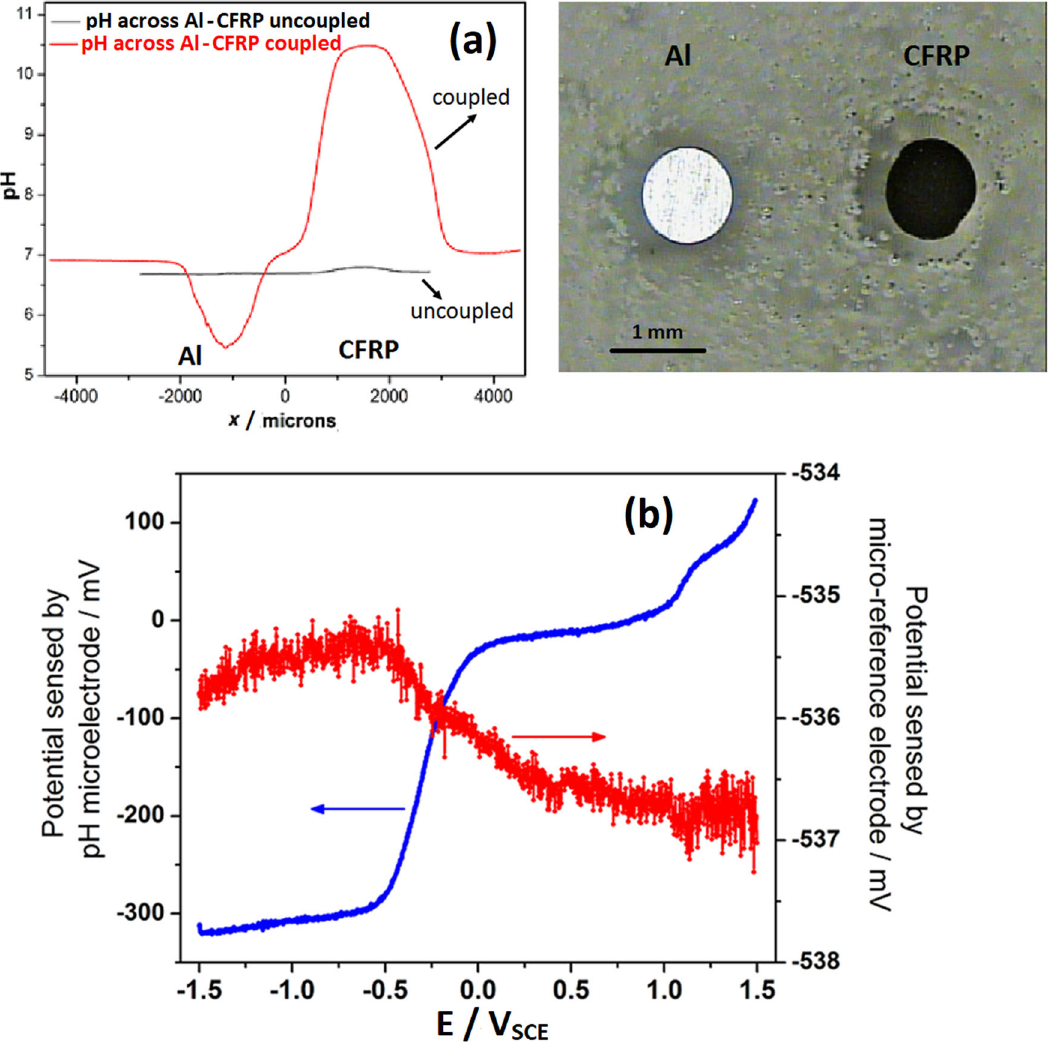
Fig. 12 Variation of local environment around Al and CFRP in Al-CFRP. Local environment information around CFRP and aluminium a pH pro fi le across Al and CFRP galvanically coupled and uncoupled in 50 mM NaCl at 12 microns from the surface, and b potentials sensed by pH microelectrode and micro-reference electrode respectively at different applied